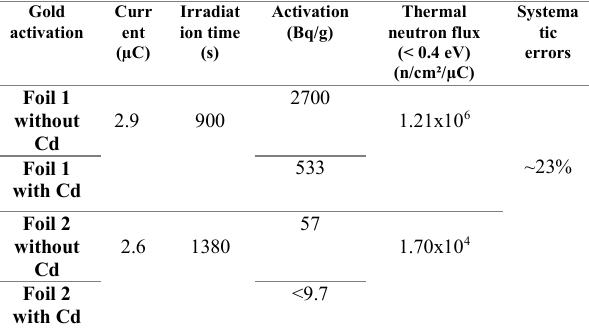
Table 1. The measured activation foils were used to reduce thermal neutron flux (less than 0.4